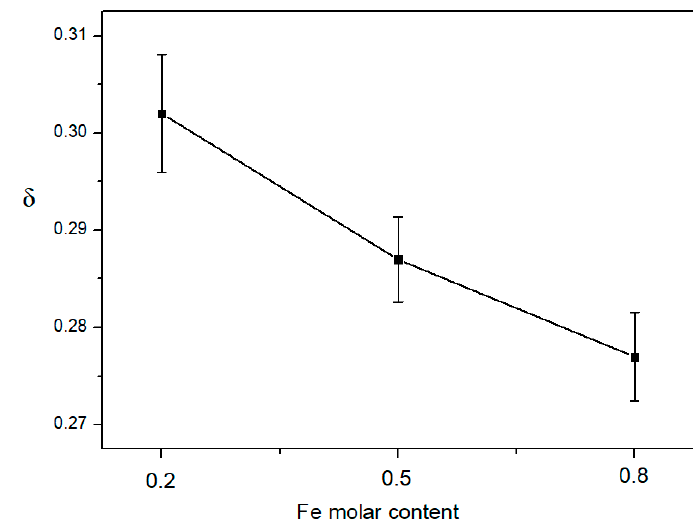
Figure 5. The oxygen non-stoichiometry of La 0.5 Ca 0.5 Co 1 − y Fe y O 3 − δ (y = 0.2, 0.5, 0.8).